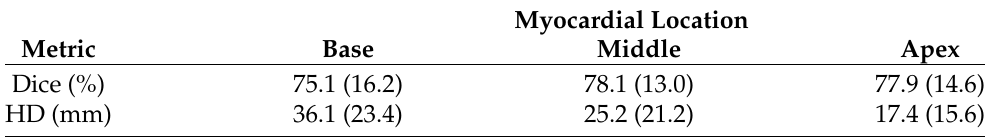
Figure 5. Scar segmentations obtained per algorithm at different heart locations. ( a ) Ground-truth. ( b ) Full-width at half-maximum. ( c ) Gaussian mixture model. ( d ) Otsu. ( e ) 1-SD. ( f ) 2-SD. ( g ) 3-SD. ( h ) 4-SD. ( i ) 5-SD. ( j ) 6-SD. ( k ) Proposed coarse segmentation. ( l ) Full proposed method. Table 4. Mean (standard-deviation) segmentation performance at different heart